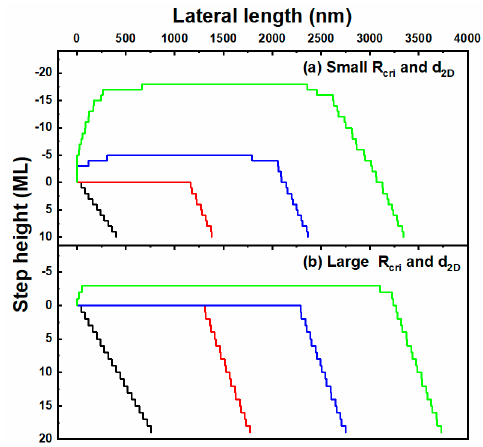
Figure 10. Simulated surface profiles of the nucleation growth on stripes at conditions of small ( a ) and large ( b ) R cri and d 2D .